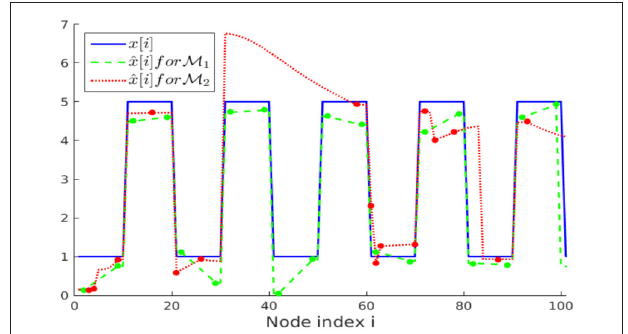
FIGURE 5 | Clustered graph signal x [ · ] along with the recovered graph signals obtained from noisy signal samples set M 1 (Lemma 2) and M 2 (random).